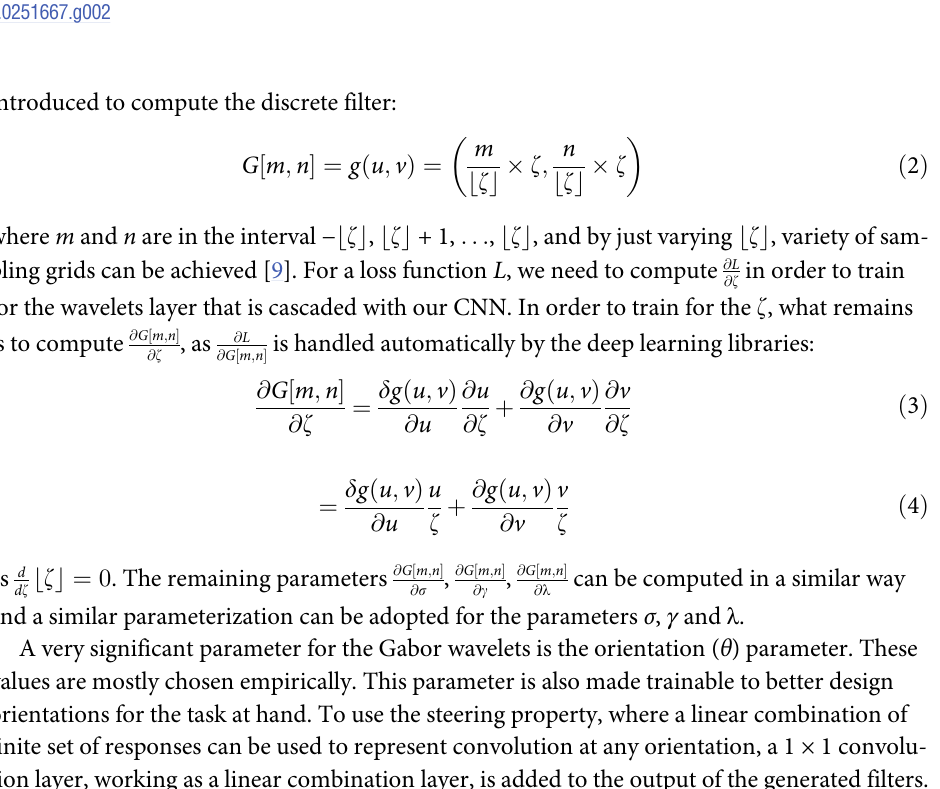
Fig 2. Trainable Gabor Wavelets (TGW) layer [9]: Inputs and outputs are multichannel. A neural network is used to generate Gabor wavelets hyperparameters. These generated Gabor filters are then applied to the input. 1 × 1 convolution layer is added to enable the steerability of the Gabor